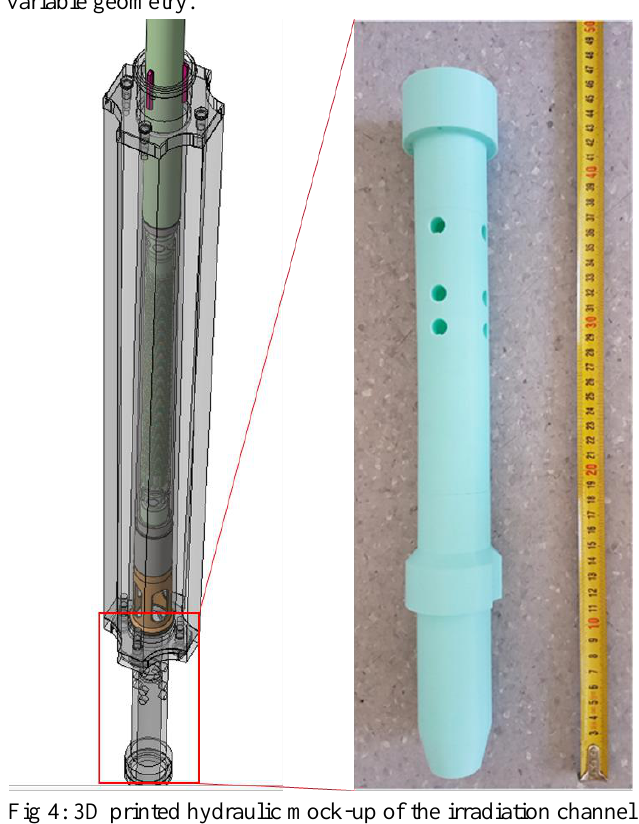
Fig 4: 3D printed hydraulic mock-up of the irradiation channel outlet. Multiple outflows visible. On the left the whole irradiation channel, filled with the ISHTAR device is